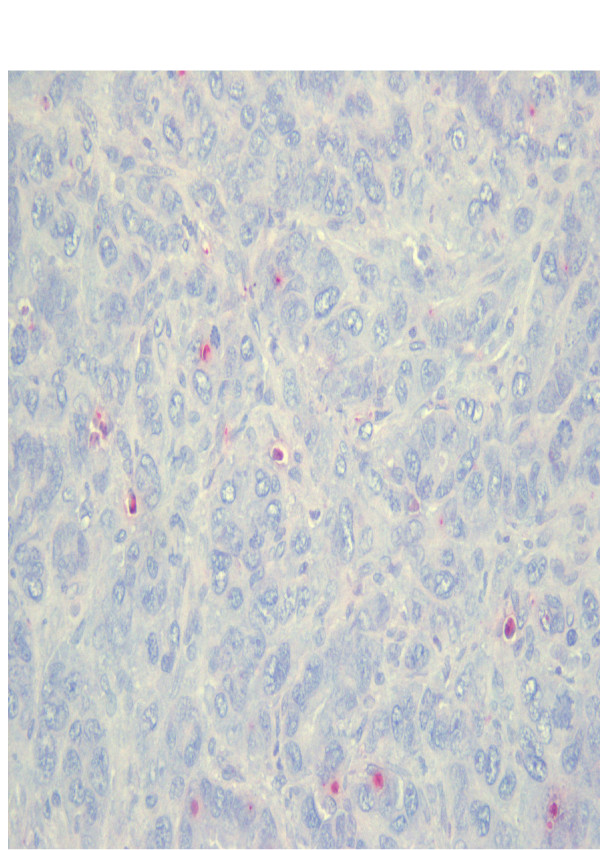
Immunohistochemical staining group I (control): Apoptosis are represented by red clusters. The index represented the number of visible apoptotic cancer cells in five fields